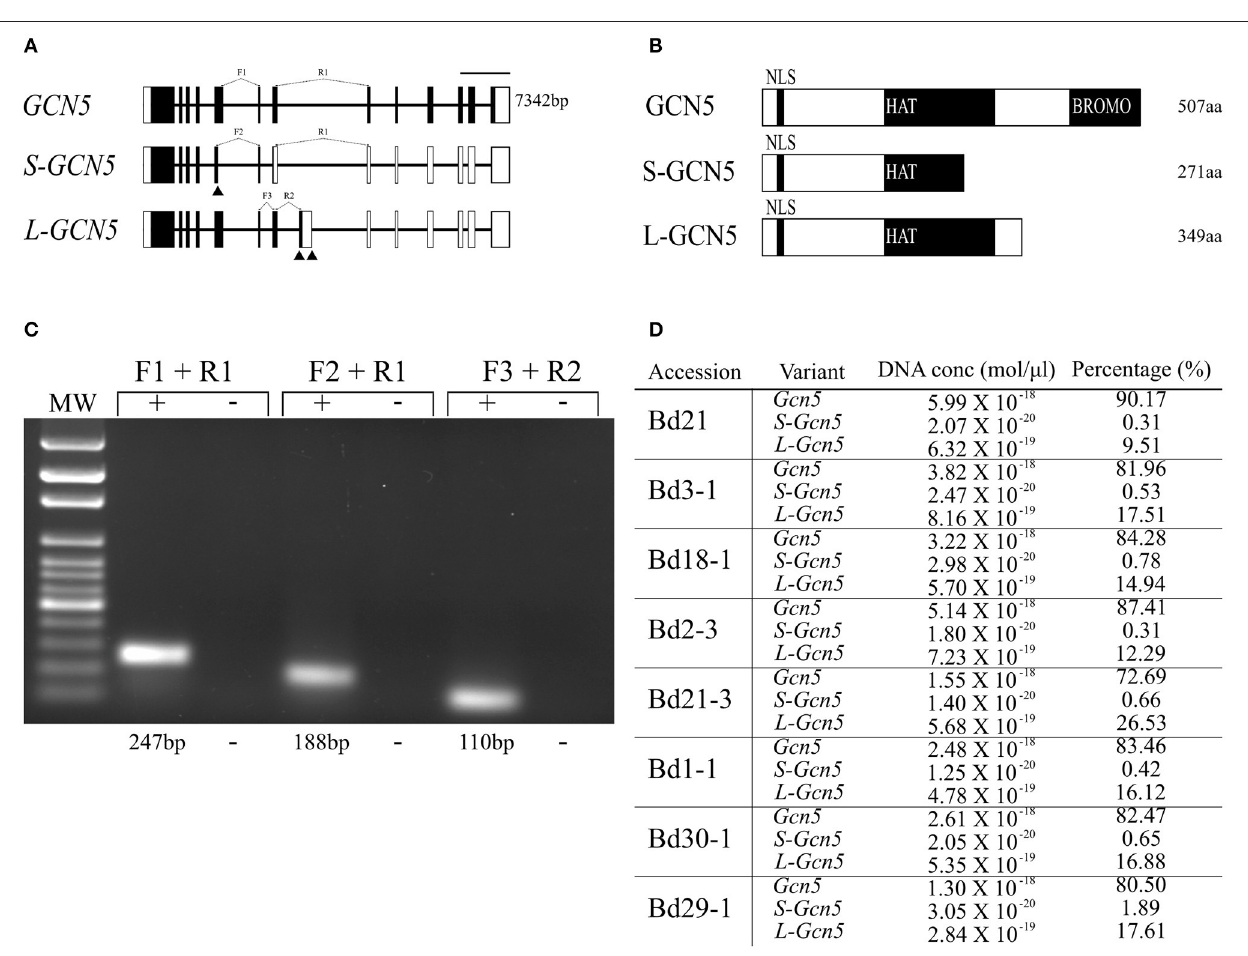
FIGURE 1 | BdGCN5 splice variants differ in their conserved domain composition and absolute transcript abundance. (A) Genomic representation of GCN5 alternative transcripts. Exons are depicted as black boxes, UTRs are depicted as white boxes. Forward (F) and reverse (R) primers used for qPCR are presented at their appropriate locations. Black arrows represent alternative splice sites. Scale bar = 1,000 bps. (B) Predicted protein product representation of BdGCN5 variants. Black boxes represent conserved protein domains. NLS, nuclear localization signal; HAT, histone acetyltransferase domain; and BROMO, Bromodomain. (C) Confirmation of specific detection of BdGCN5 splice variants through qPCR, using the primer pairs depicted in (A) , MW, molecular weight marker. (D) Absolute RNA quantification of each BdGCN5 variant is presented as an absolute value in mol/ µ l of input cDNA (the cDNA reaction contained 75 ng/ µ l of input RNA from aerial tissue extractions), as well as the percentage of the total BdGCN5 transcript pool in each tested